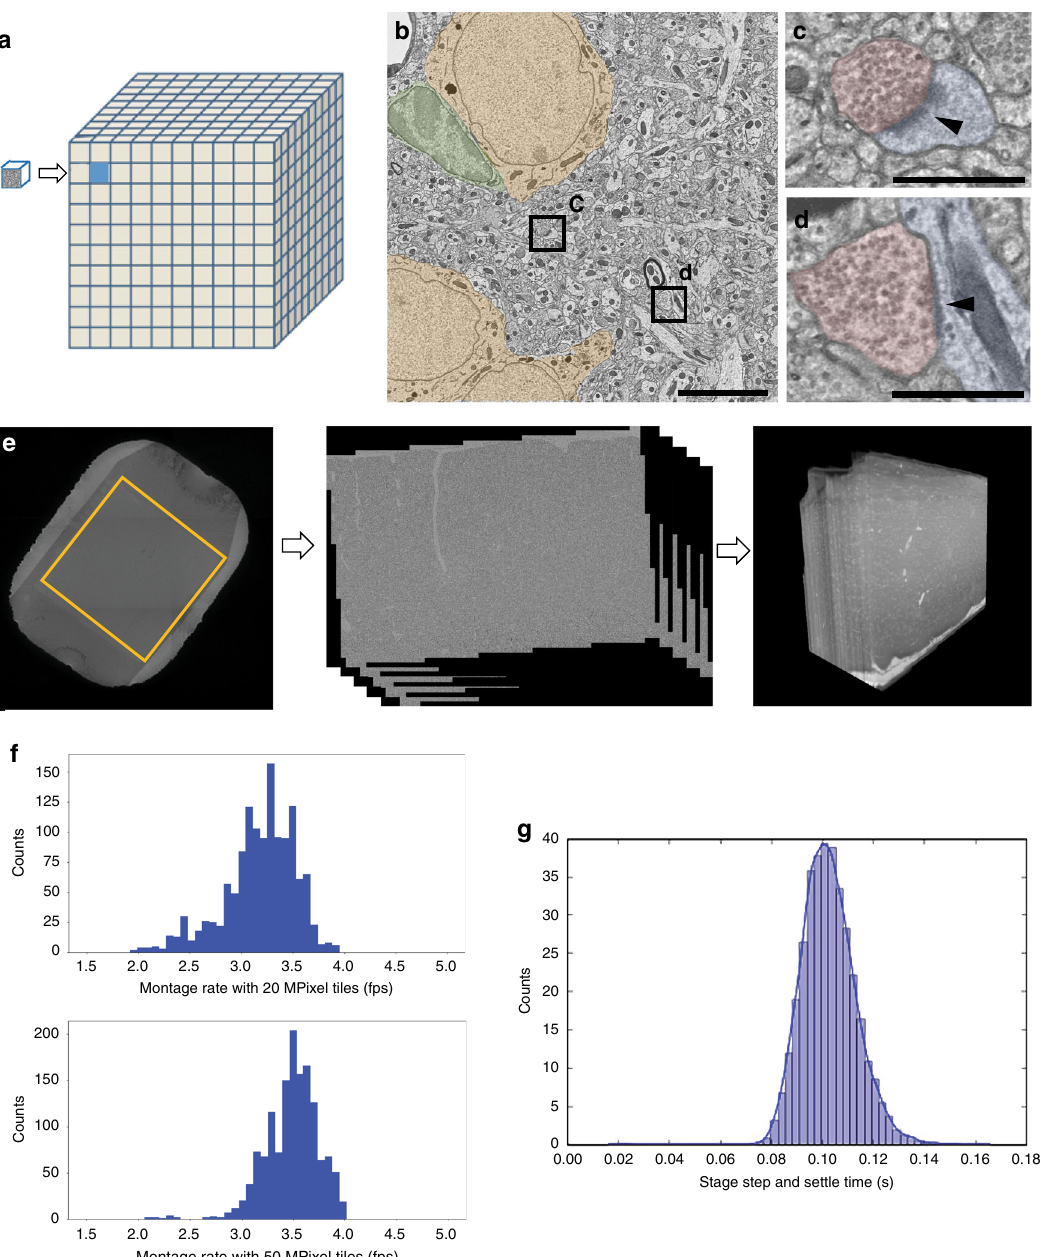
Fig. 4 Imaging of a cubic millimeter of mouse cortex with piTEAM. a Scaling from 0.003 mm 3 to 1 mm 3 , a 300-fold volume increase; b High-resolution electron microscopy image tile from the 1 mm 3 dataset with neuronal somata highlighted in yellow and glia in green (scale bar 5 µ m). c Zoomed-in area from ( b ) showing synapse with dendritic spine (scale bar 1 µ m); d Zoomed-in area from ( b ) showing synapse with dendritic shaft (scale bar 1 µ m); e Low- mag EM image of an aperture with an ROI highlighted; 2D stacked montage minimap and aligned 3D volume. f Distribution of montage acquisition rate (frames per second) achieved during 1 mm 3 production. The plots represent a sample size of over 1000 sections imaged by 20 Mpixel and 50 Mpixel cameras each. g Example of stage step-and-settle time distribution for